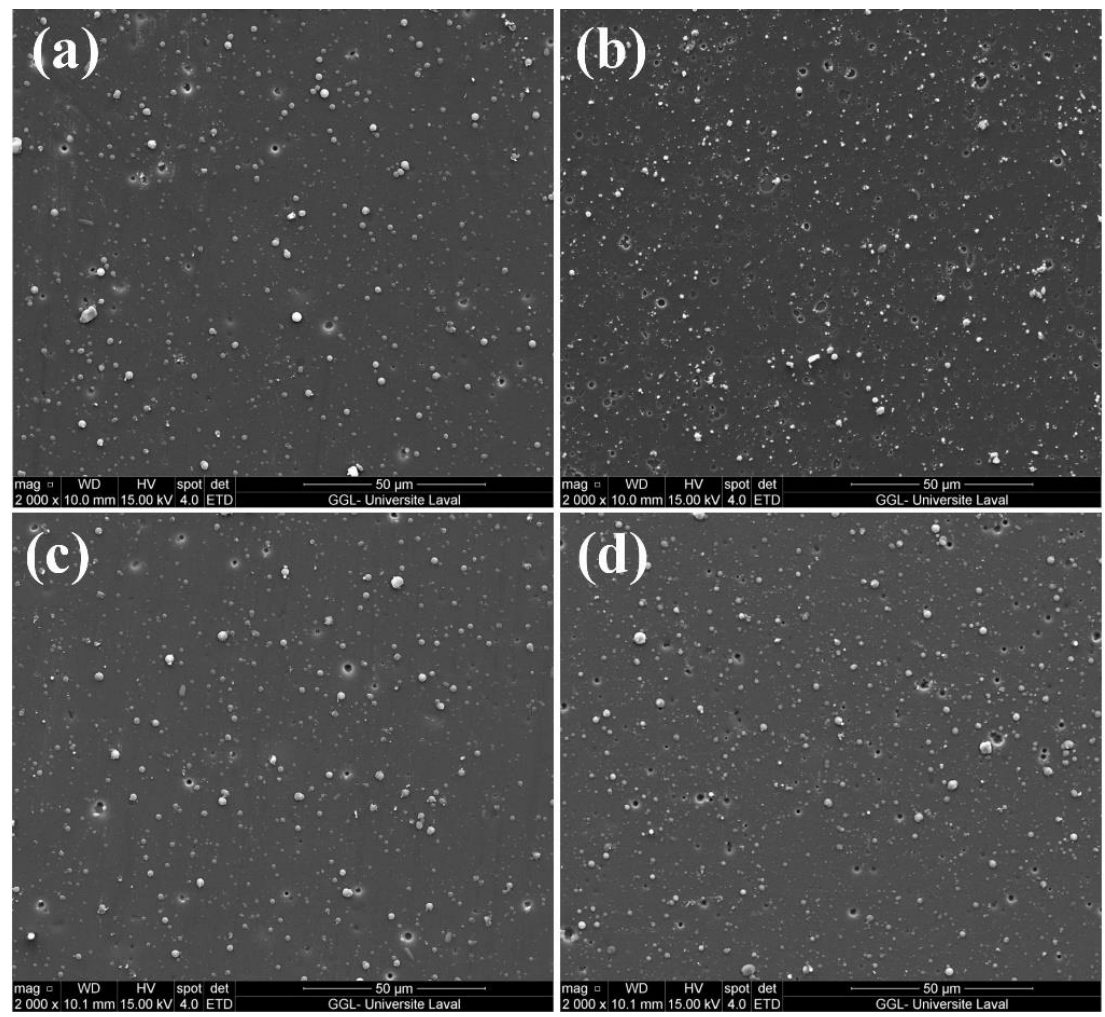
Figure 7. Surface morphology of coatings ( a ) CrN/CrCN/DLC, ( b ) CrN/AlTiN, ( c ) CrN/CrCN, and ( d ) CrCN/TiSiCN.